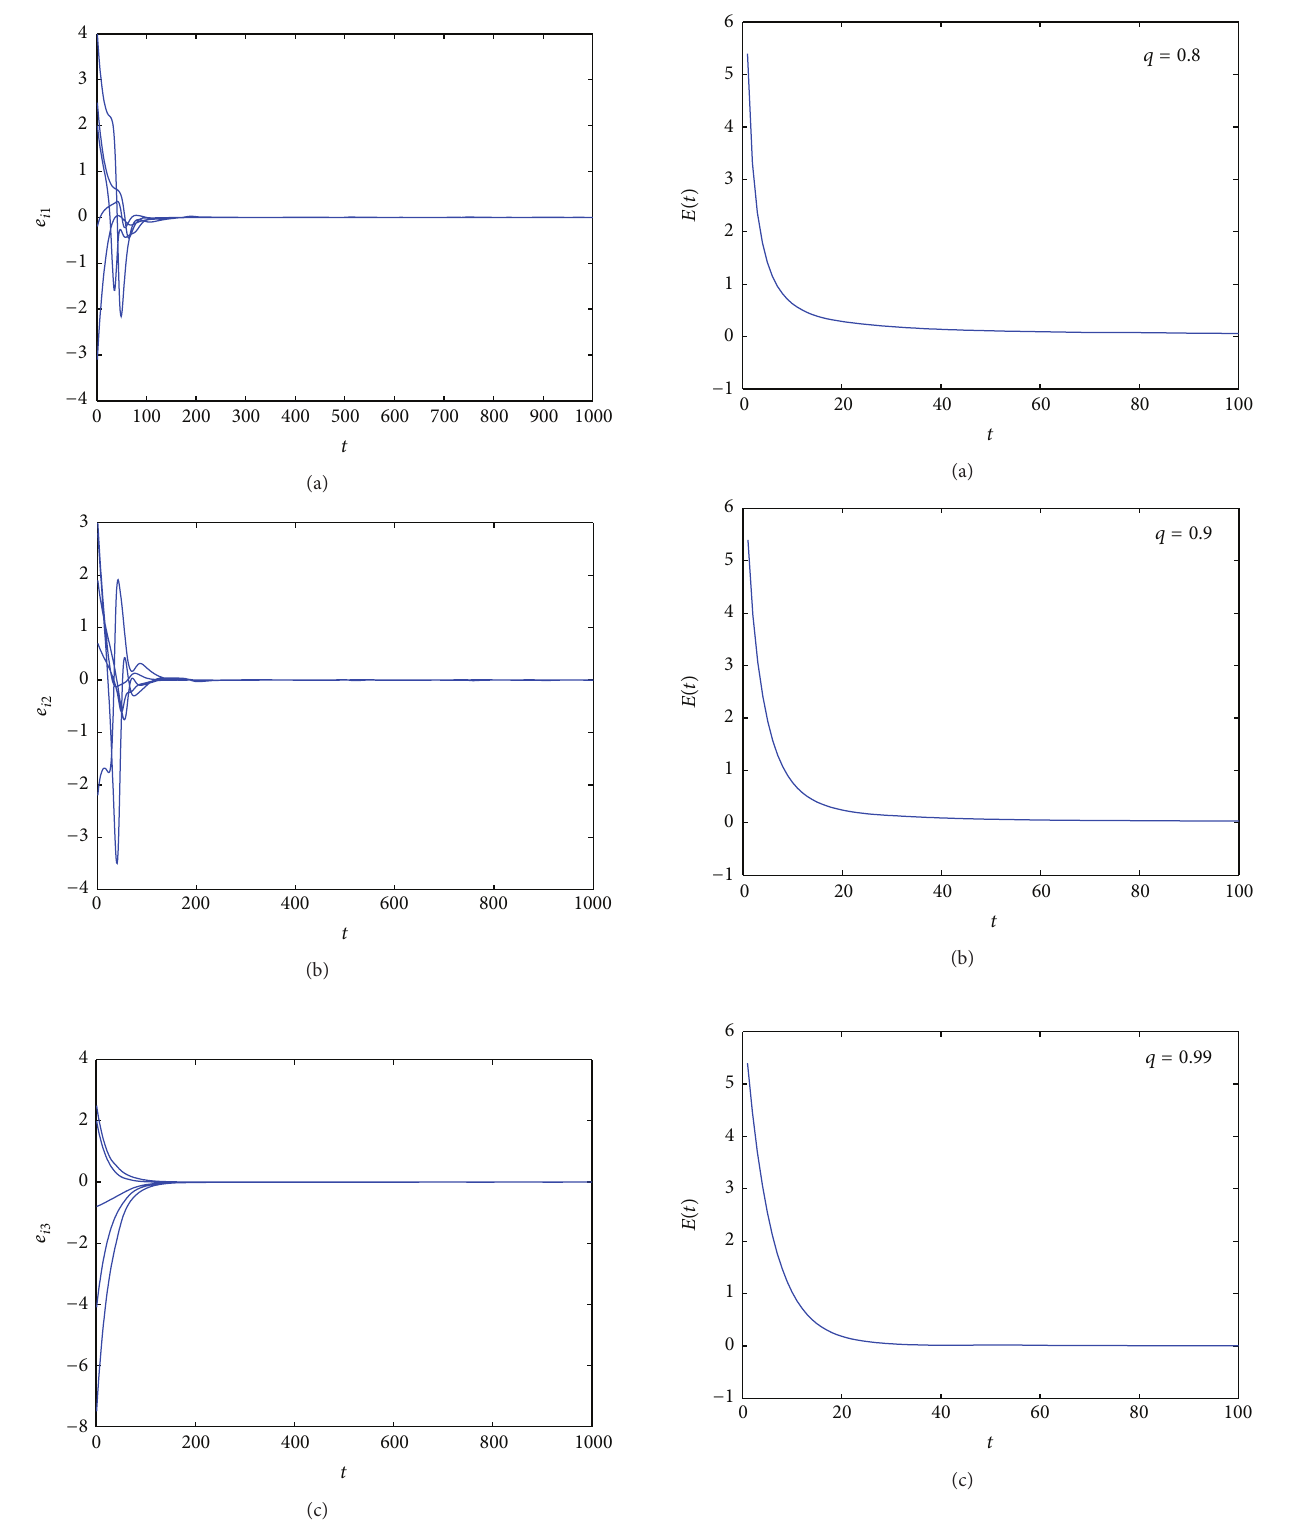
Figure 4: Time evolutions of synchronization error 𝐸(𝑡) with different values of fractional order 𝑞